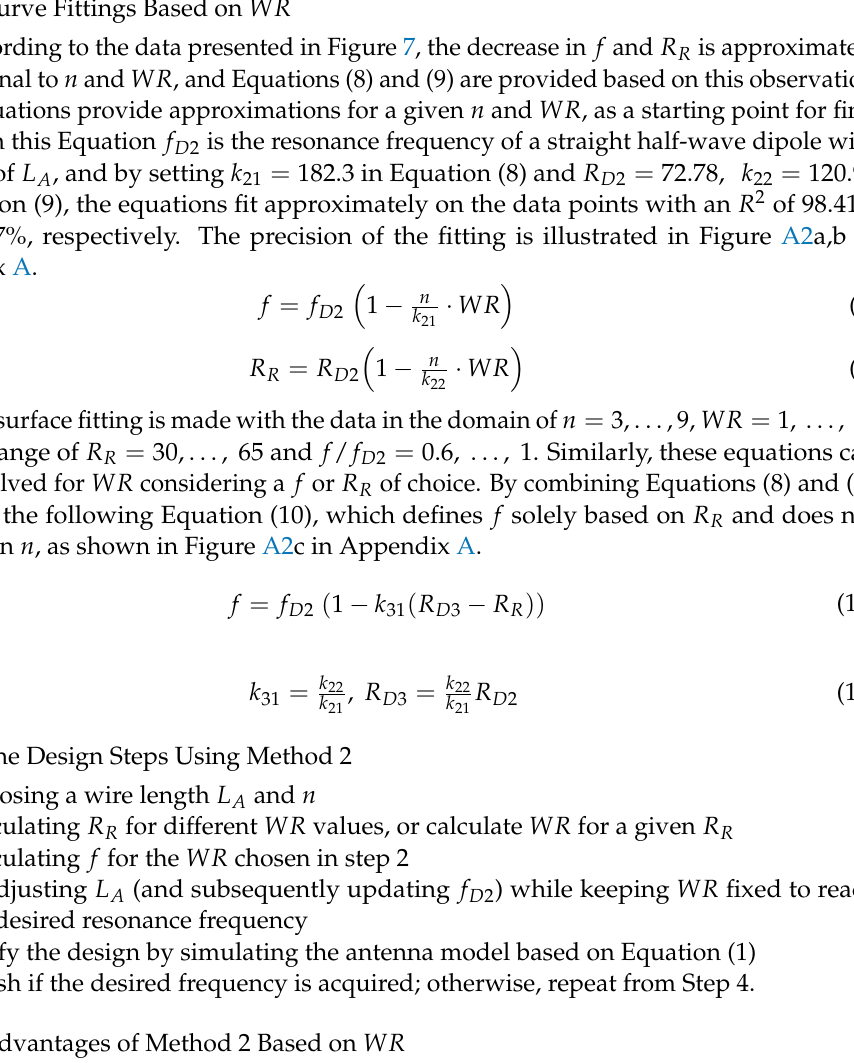
Figure 7. Antenna characteristics for different n values expressed versus 𝑊𝑅 while the axial length 𝐿 𝐴 is kept constant ( a ) Radiation Resistance of the antenna on resonance frequency. The required 𝑊𝑅 values to design a 50 Ω antenna are marked for 𝑛 = 3, … ,9 ( b ) Resonance frequency normalized to 𝑓 𝐷2 .